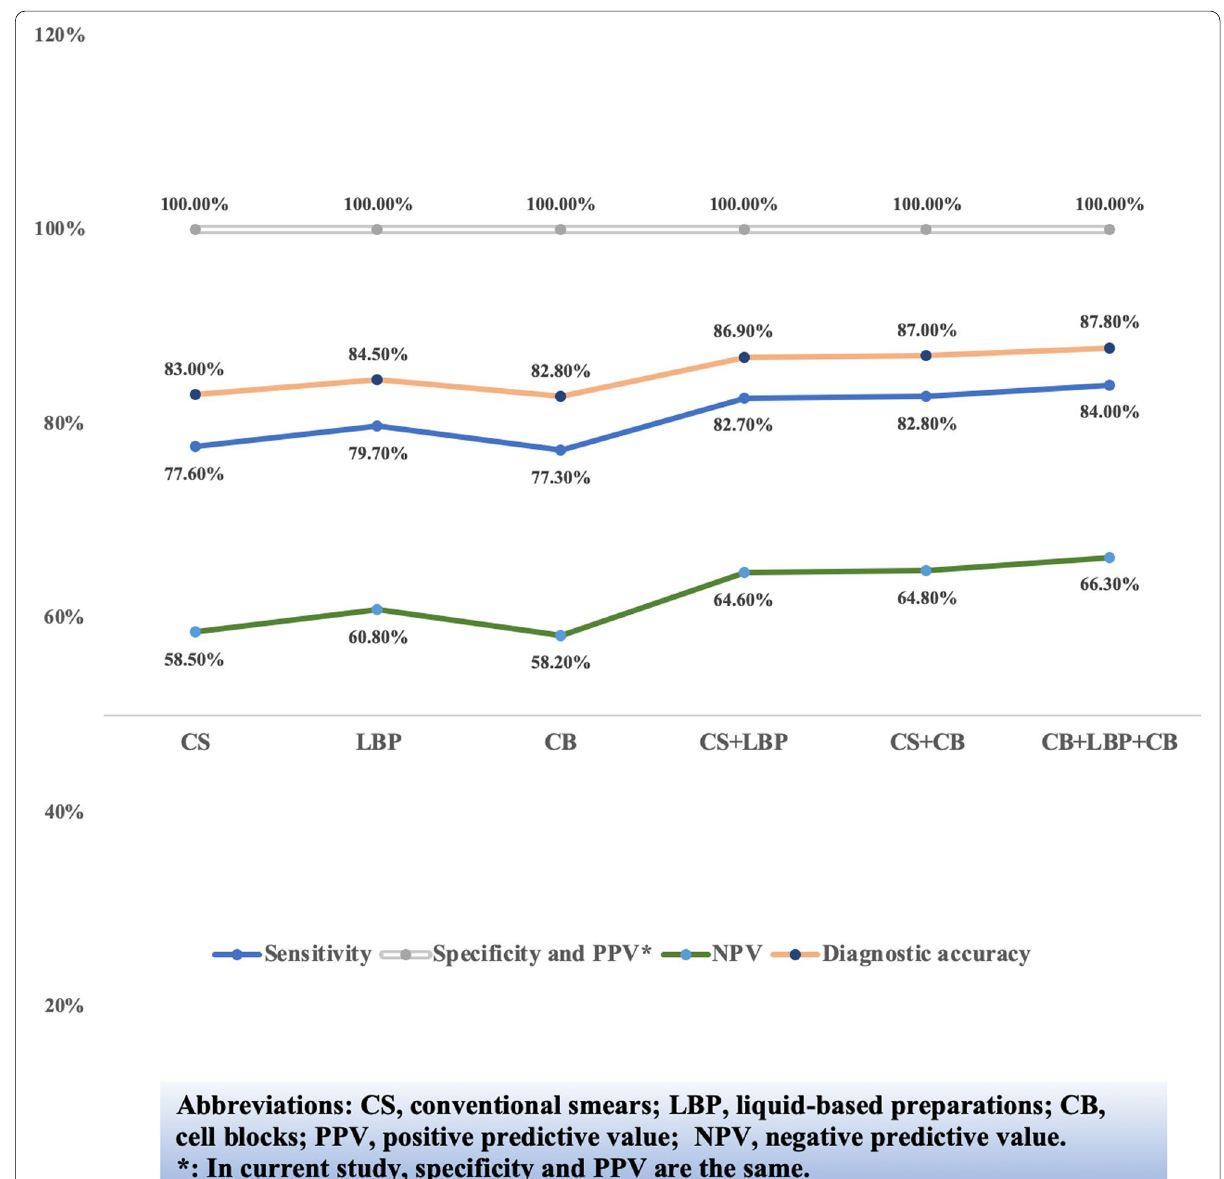
Fig. 3 The performance evaluation among different sample preparations in 1288 cases when considering malignancy, suspicious of malignancy and atypia of undetermined significance as